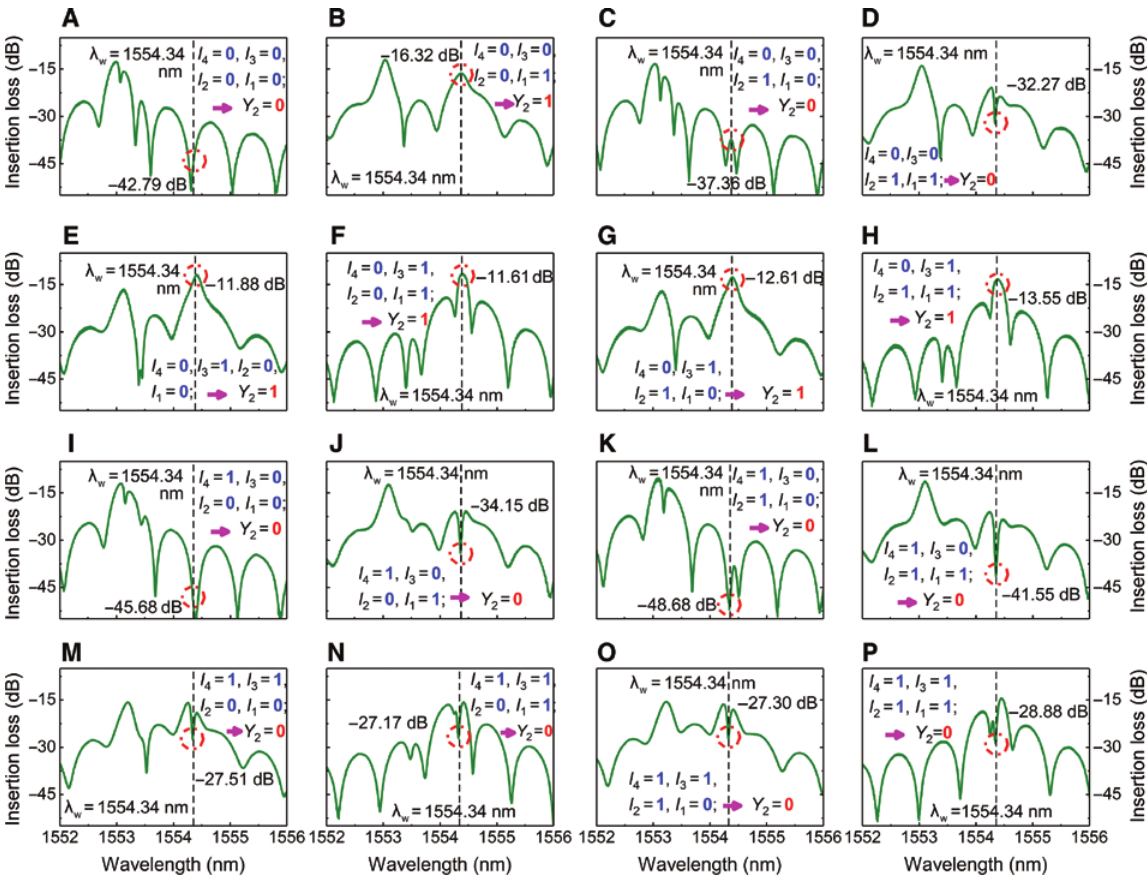
port under different combinations of voltages. 2 , MRR , MRR , and MRR are 1.54, 1.69, 1.78, and 1.46 V, respectively, while the low levels are all 0 V. 4 3 2 1